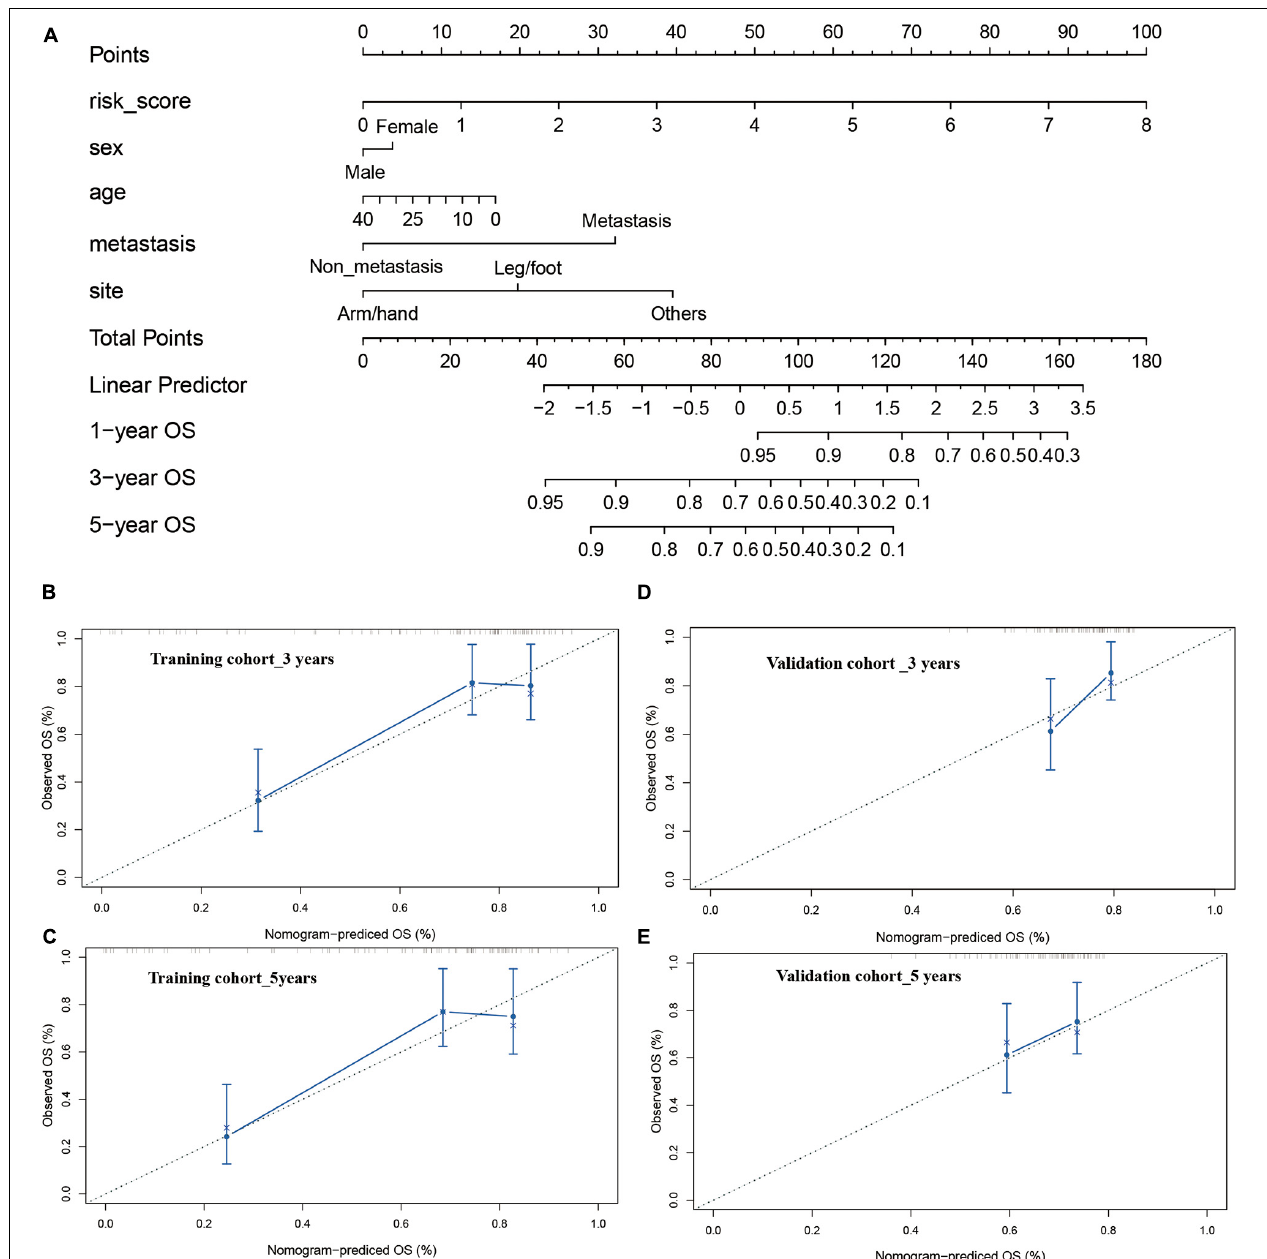
FIGURE 8 | Construction and calibration of nomogram. (A) nomogram integrating risk score and clinical features, (B,C) calibration of the nomogram at 3 and 5 years in the training cohort, (D,E) calibration of the nomogram at 3 and 5 years in the verification